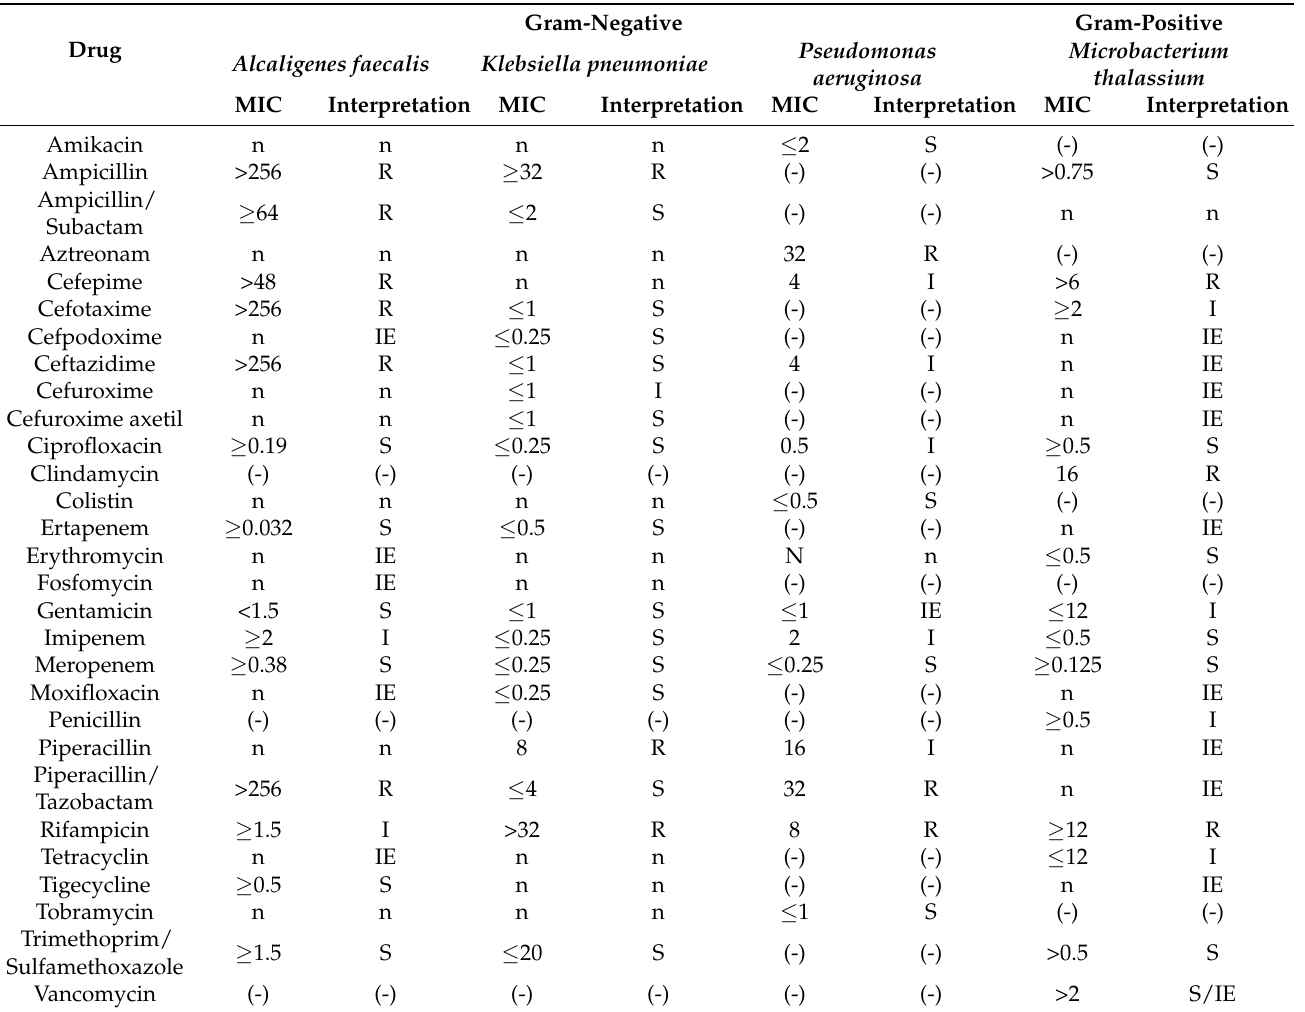
Table 2. Antibiotic susceptibility test of putative bacterial entomopathogens. MIC ( µ g · mL − 1 ) inter- pretative criteria were taken from the susceptibility breakpoint specifications of CLSI and EUCAST [33,34]. Interpretation abbreviations are defined as follows: susceptible (S), intermediate (I), resistant (R), insufficient evidence (IE), no suitable target (-), not determined (n).